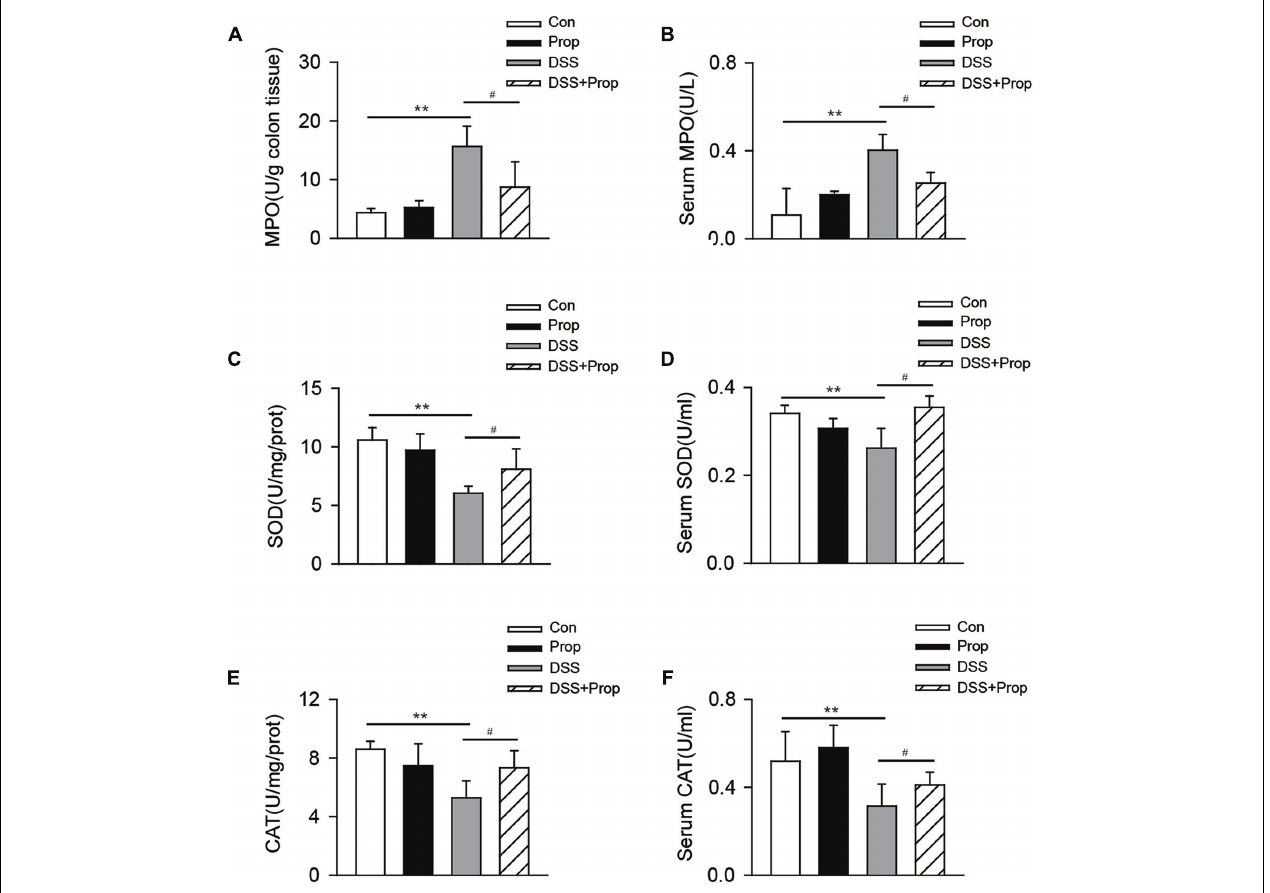
FIGURE 4 | The effects of sodium propionate on oxidative stress response in colitis mice. MPO, SOD, and CAT levels in colonic tissues were determined (A,C,E) . MPO, SOD, and CAT levels in serum were shown (B,D,F) . Data are presented as mean ± SD. n = 10 per group, ∗ P < 0.05, ∗∗ P < 0.01 vs. control group; # P < 0.05, ## P < 0.01 vs. DSS